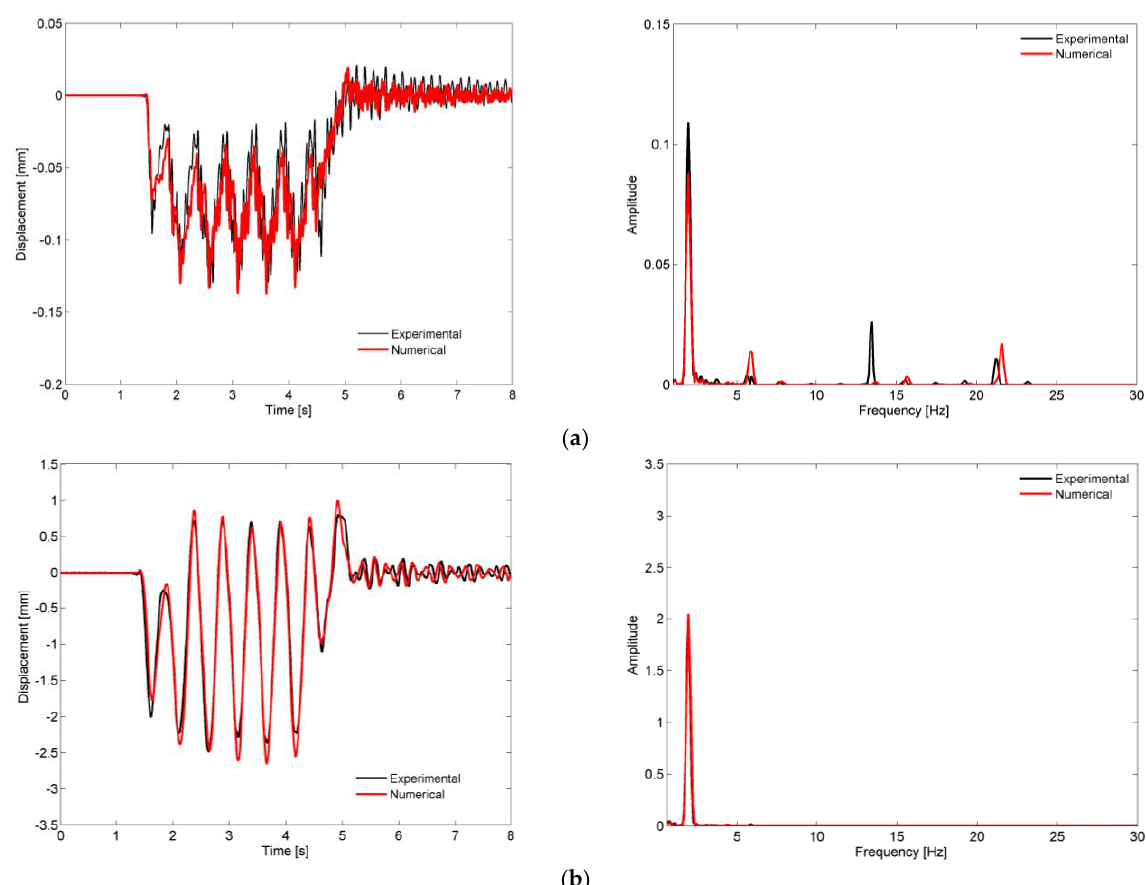
Figure 19. Comparison of displacement records and respective auto-spectra for the passage of Alfa Pendular train at a speed of 180 km/h, obtained experimentally and numerically, at locations ( a ) D1 and ( b ) D3.